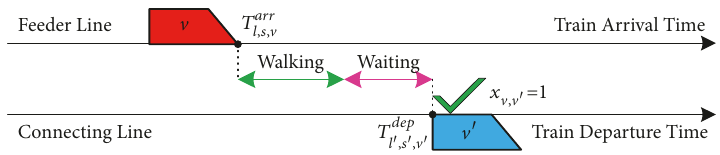
Figure 1: The successful transfer